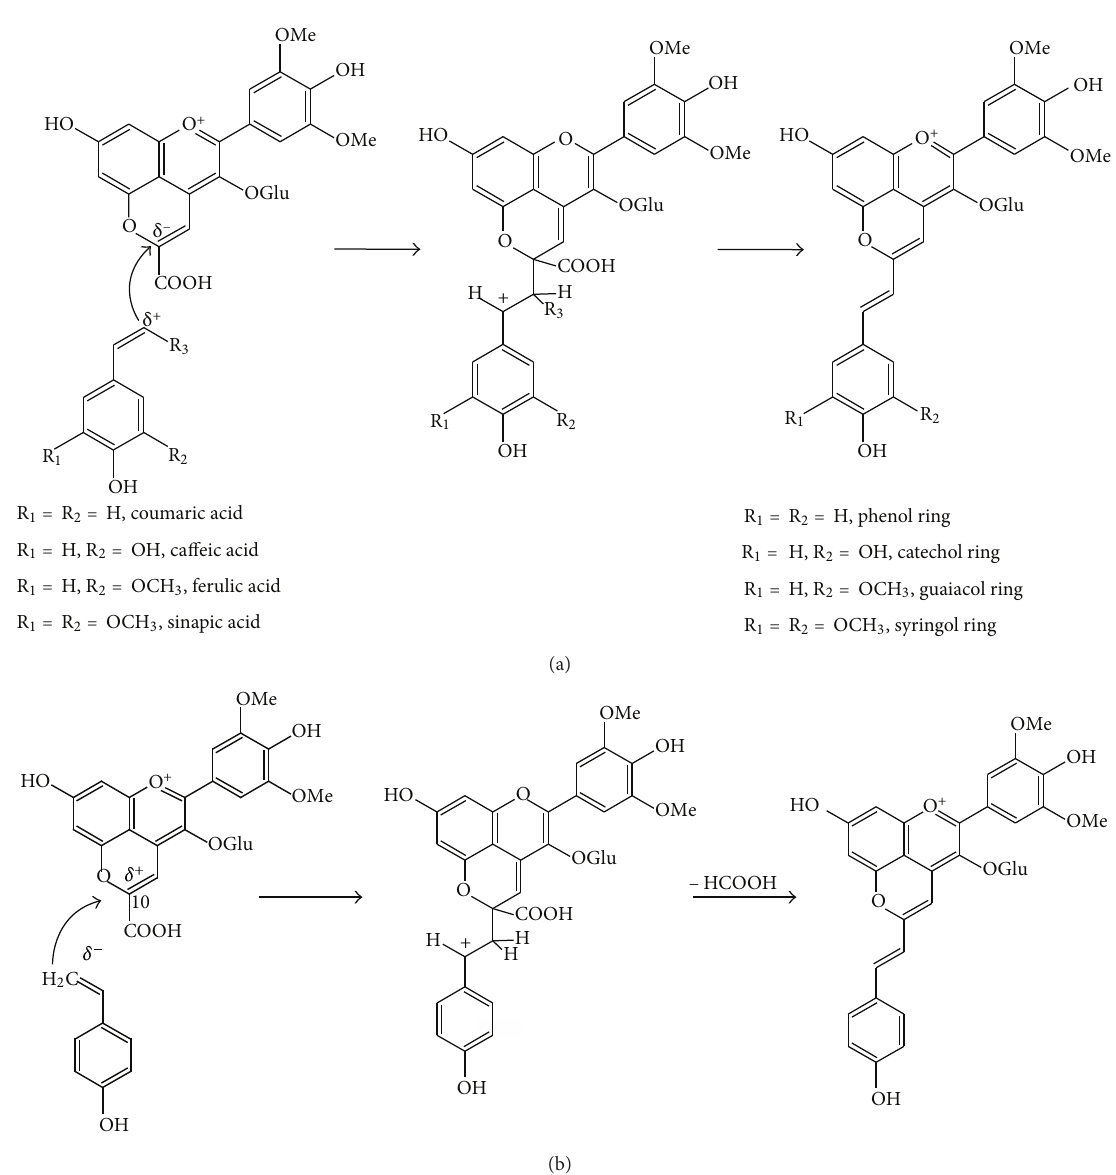
F 10: Proposed mechanisms for the formation of type B portisins (a) and the formation of vinylpyranomalvidin-3- O -glucoside-phenol (b)